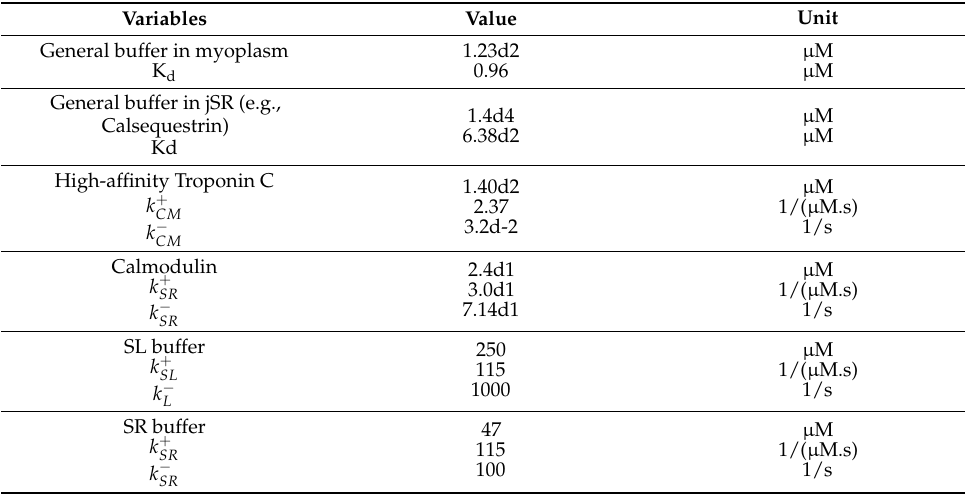
Table A4. Calcium